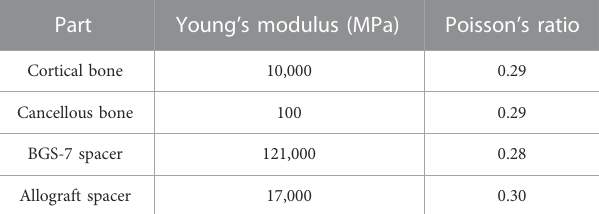
TABLE 2 Material properties applied to fi nite element analysis.